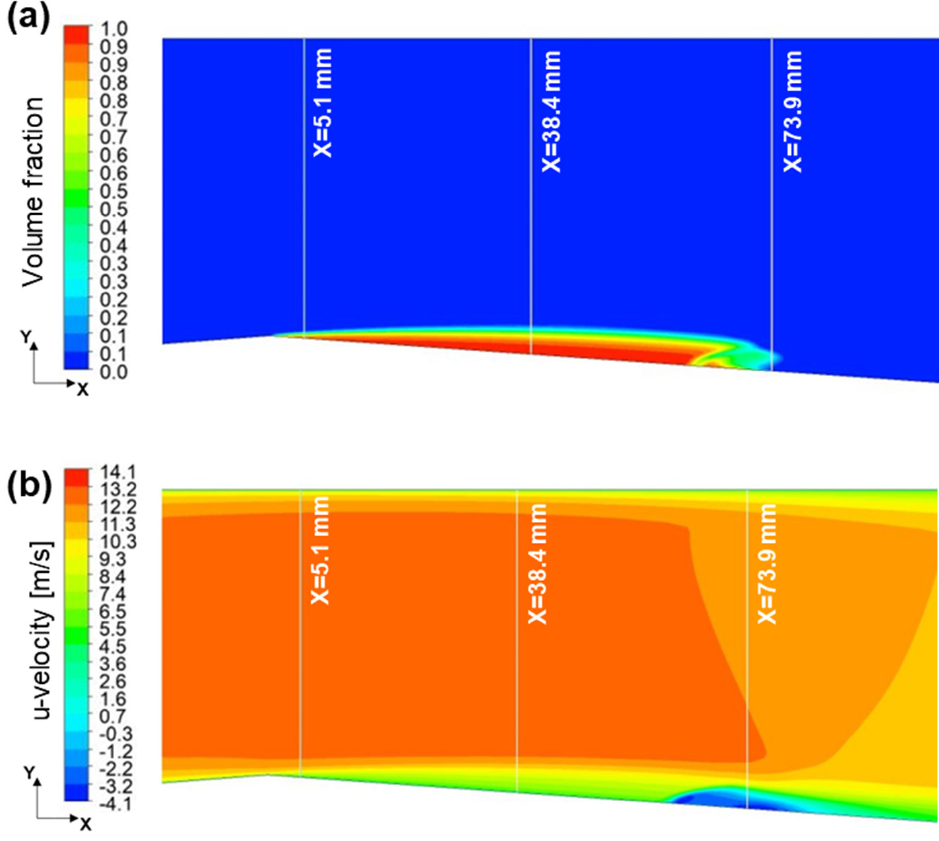
Table 6. Grid test results.